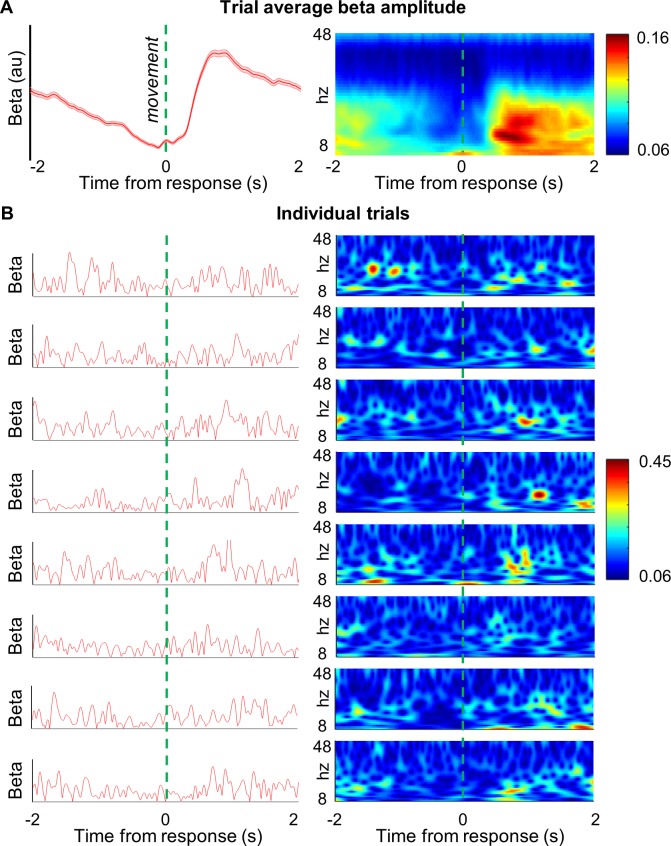
Single trial beta events do not match the dynamics of trial-averaged beta activity.(A) Time series of trial-averaged contralateral M1 beta amplitude (13–30 Hz; subject 2; block 1; mean ± SEM 535 trials; left panel). This shows classical ERD and ERS in the pre- and post-movement periods, respectively. Trial-average time-frequency amplitude spectrogram (same subject; wavelet decomposition; see Materials and methods; right panel) showing a reduction in spectral activity specific to the beta band in the period prior to movement, followed by an increase following movement. (B) Individual trial data from the same subject (no. 2; run 3; trials 250–258) as the beta amplitude envelope (red; left panels) and as time-frequency amplitude spectrograms (right panels). At the single trial level, beta amplitude does not closely resemble the trial average but appears highly dynamic with short lasting bursts, which are more common around the time of the average ERS. The underlying data can be found in the post-processed files (Subj2Run3.mat) at https://osf.io/eu6nx/. ERD, event-related desynchronisation; ERS, event-related synchronisation.